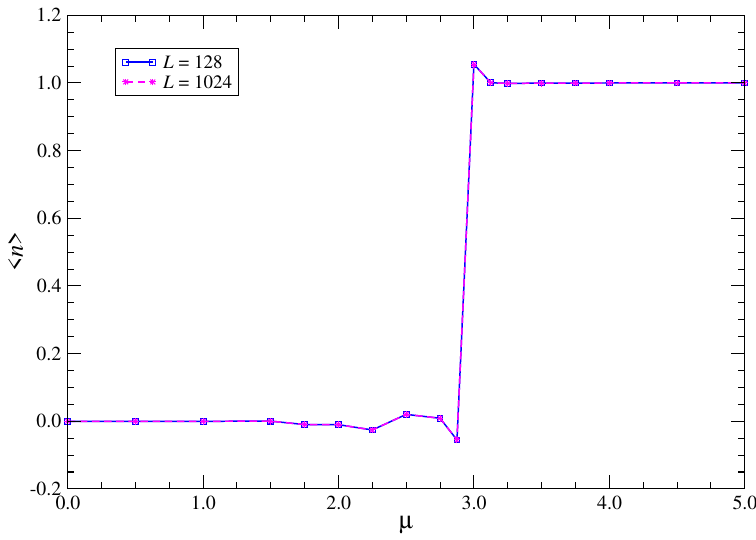
Figure 9 . Particle number density at m = 0 . 01 as a function of µ on 128 4 and 1024 4